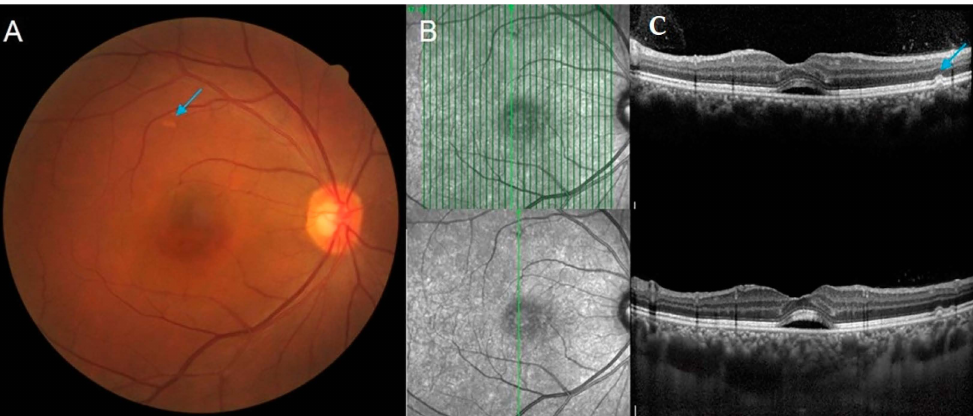
Figure 1. Representative cases of pachydrusen in CSC eye. ( A ) A 53-year-old male patient presented with CSC in his right eye, with a pachydrusen (blue arrows) in FP. ( B ) A solitary pachydrusen is noted superior to the fovea, and ( C ) thick subfoveal choroidal thickness (533 µ m) with subretinal fluid is noted in the enhanced depth imaging mode. CSC = central serous chorioretinopathy; FP = fundus photography.